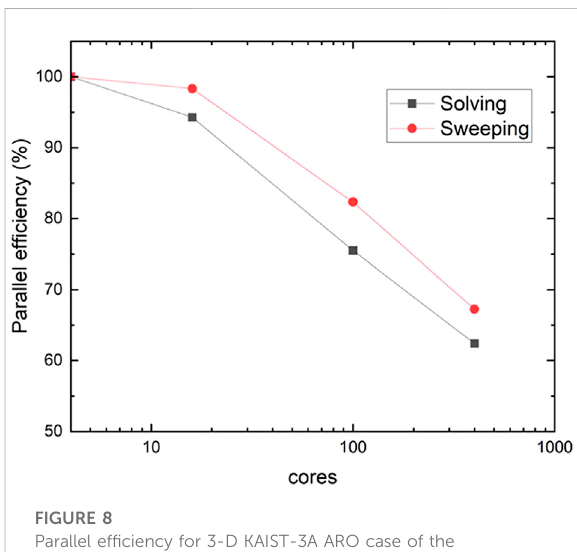
FIGURE 8 Parallel ef fi ciency for 3-D KAIST-3A ARO case of the comePSn_JFNK code.